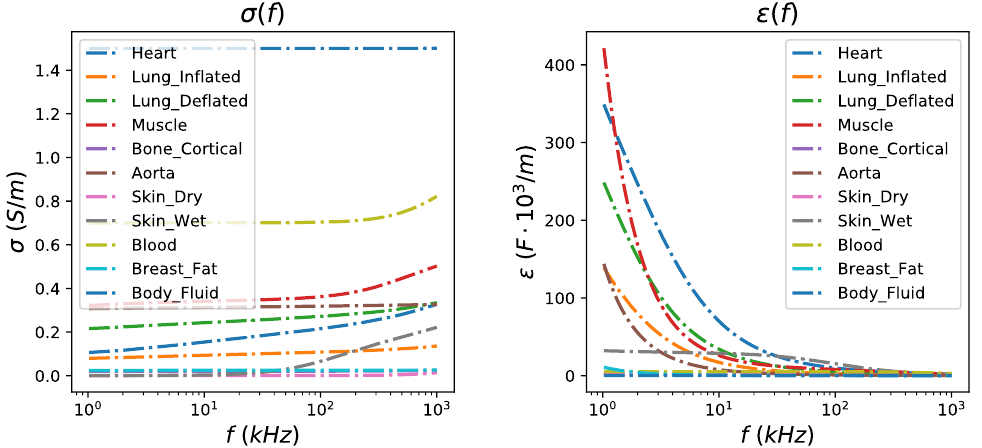
Figure 3. Left : Relative conductivity per thoracic tissue in the frequency range between 1 kHz and 1 MHz. Right : Relative permittivity per thoracic tissue in the frequency range between 1 kHz and 1